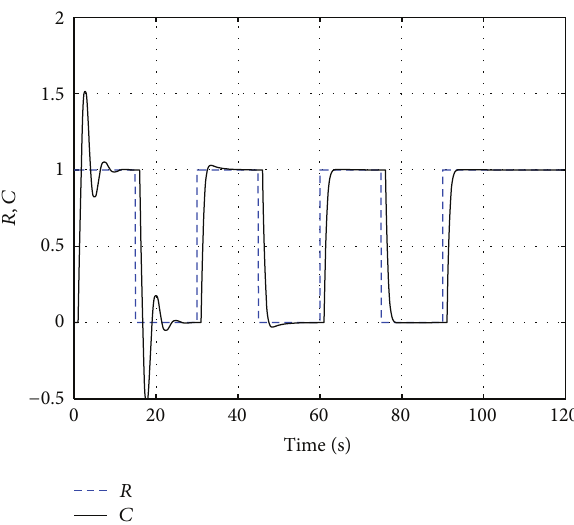
Figure 10: Online autotuning process of Example 1.